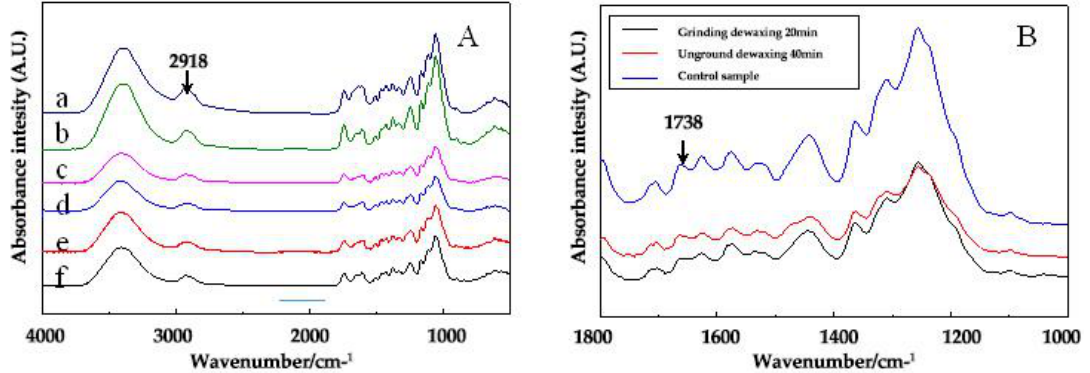
Figure 1. The infrared spectrum and the local magnified infrared spectrum after the processing time of the sonication and chloroform treatment to the poplar catkin fiber (PCF) after dewaxing treatment (( A ) is the total infrared spectrum, ( B ) is the local large infrared spectrum a is the control sample, b–e are only dewaxing without sonication for 20, 40, 60, 80 min, f is sonication and dewaxing for 20